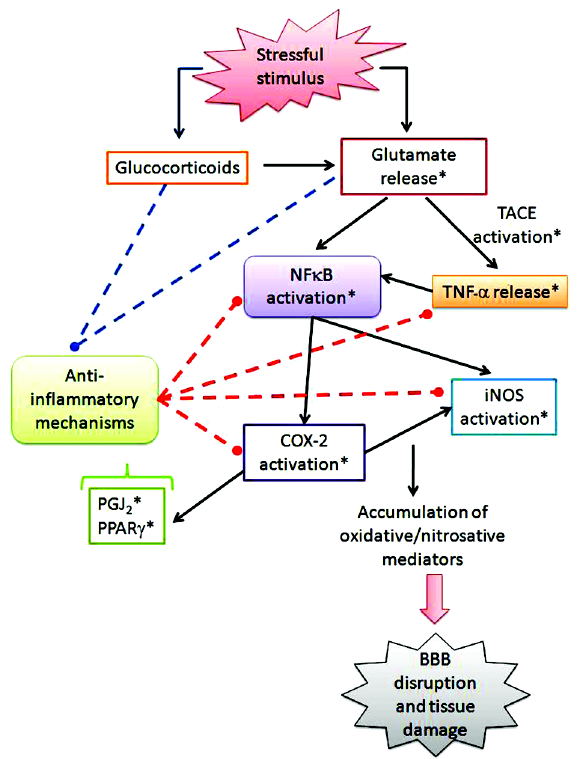
Figure 1. Stress-induced oxidative/nitrosative mediators in the brain. TACE = TNF- α convertase; NF κ B = nuclear factor kappa B; TNF- α = tumor necrosis factor alpha; iNOS = inducible nitric oxide synthase; COX-2 = cyclooxygenase-2; PGJ 2 = prosta- glandin 15d-PGJ 2 ; PPAR γ = peroxisome proliferator-activated nuclear receptor gamma; BBB = blood-brain barrier. *Possible targets for drugs. Straight line = increase; dotted line =